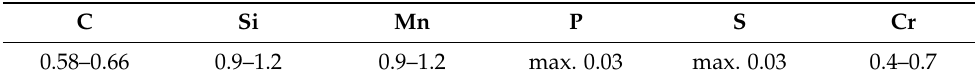
Table 2. Chemical composition of the 62SiMnCr4 machined material